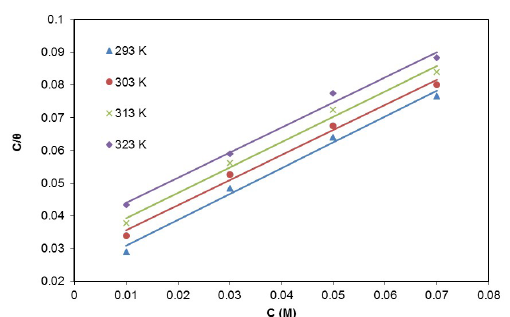
Figure 5. Langmuir adsorption isotherm plots of the steel specimens in 0.5 M HCl with different concentration of TTA (0.01 to 0.07 M) at various temperatures (293, 303, 313 and 323 K).